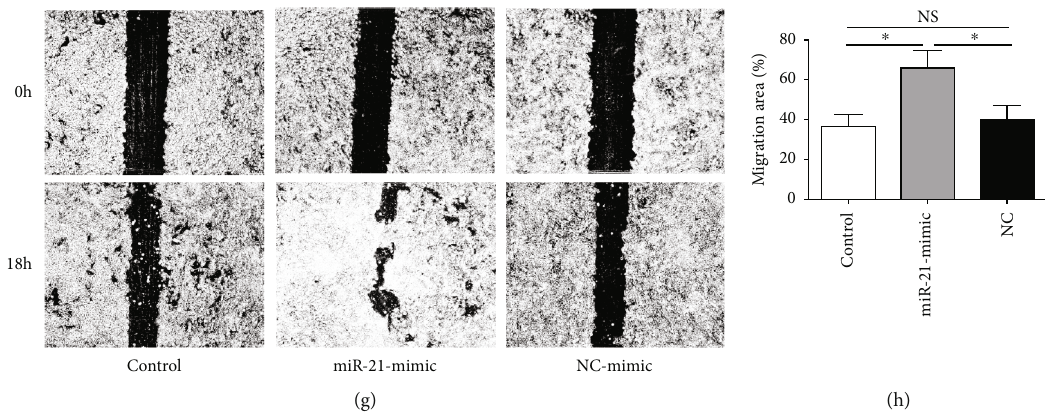
Figure 7: sEV-mediated transfer of miR-21 promotes HCEC proliferation and migration. (a, b) HCECs were treated with miR-21 KD HUMSC-sEVs or miR-21 contained HUMSC-sEVs for 18 h. The scratch assay showed the healing of the miR-21 KD HUMSC-sEV- treated group was slower than the miR-21 contained HUMSC-sEV-treated group, n = 5 . (c) The CCK-8 assay showed the proliferation of the miR-21 KD HUMSC-sEV-treated group was lower than the miR-21 contained HUMSC-sEV-treated group after 18 hours, n = 3 . (d, e) The proliferation of HCECs was detected by EdU incorporation after transfected with miR-21 mimics (at fi nal concentration of 50nM). Blue: nuclear staining (Hoechst33342); red: EdU staining, n = 3 . (f) The CCK-8 assay showed the proliferation of the miR-21 mimic group was higher than control group after 48 hours, n = 3 . (g, h) The scratch assay showed signi fi cantly faster wound closure in HCECs incubated with miR-21 mimics than NC after 18 hours, n = 5 . Data are expressed as the means ± SD . ∗ P < 0 : 05 , ∗∗ P < 0 : 01 , and ∗∗∗ P < 0 : 001 . KD: knockdown.